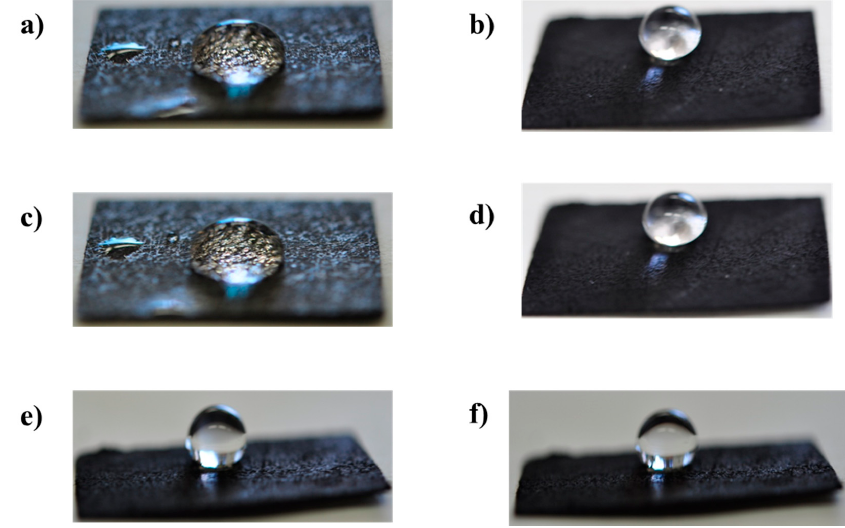
Figure 2. Pictures of a water drop on two gas di ff usion layers: Spectracarb ® (on the left) and Sigracet 35BC ® (on the right) after 0 s ( a , b ) and after 1800 s ( c , d ). Sigracet 35BC ® + FEP 7% after 0 s ( e ) and after 1800 s ( f